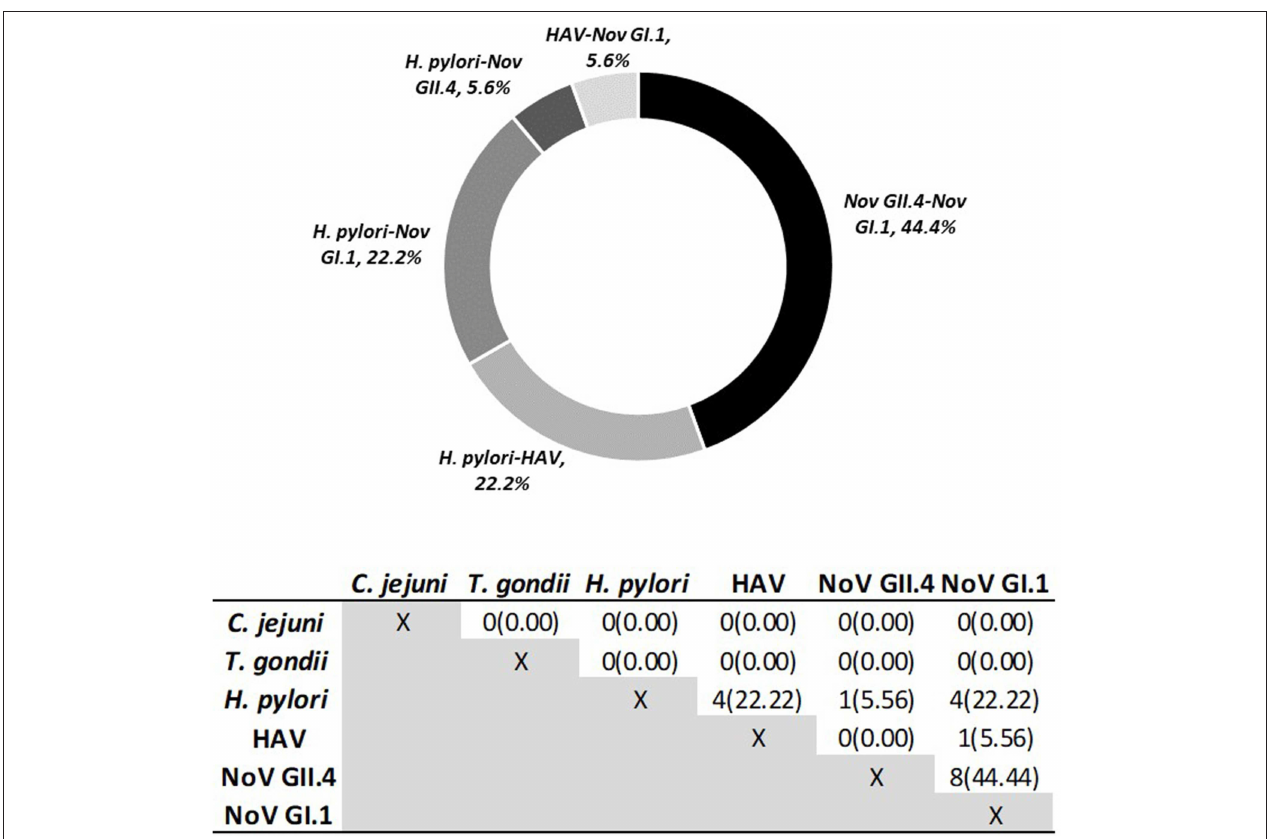
FIGURE 4 | Co-Immunoconversions to specific pathogen pairs calculated using Criteria B. Number of individuals ( n ) who immunoconverted to both pathogens